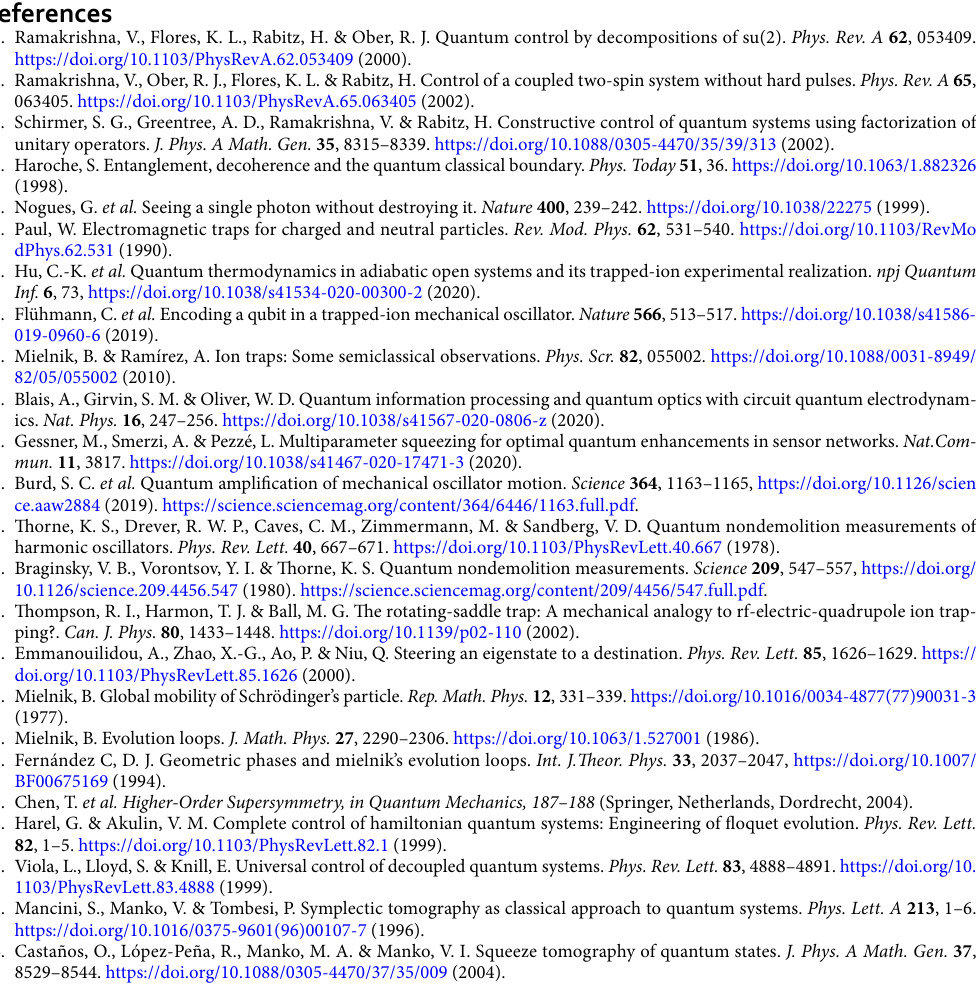
idea of frictionless driving , which transports the states without changing the eigenvalues of certain invariants. But could the more general variational methods be applied at the level of a θ( t ) function? The question remains open.